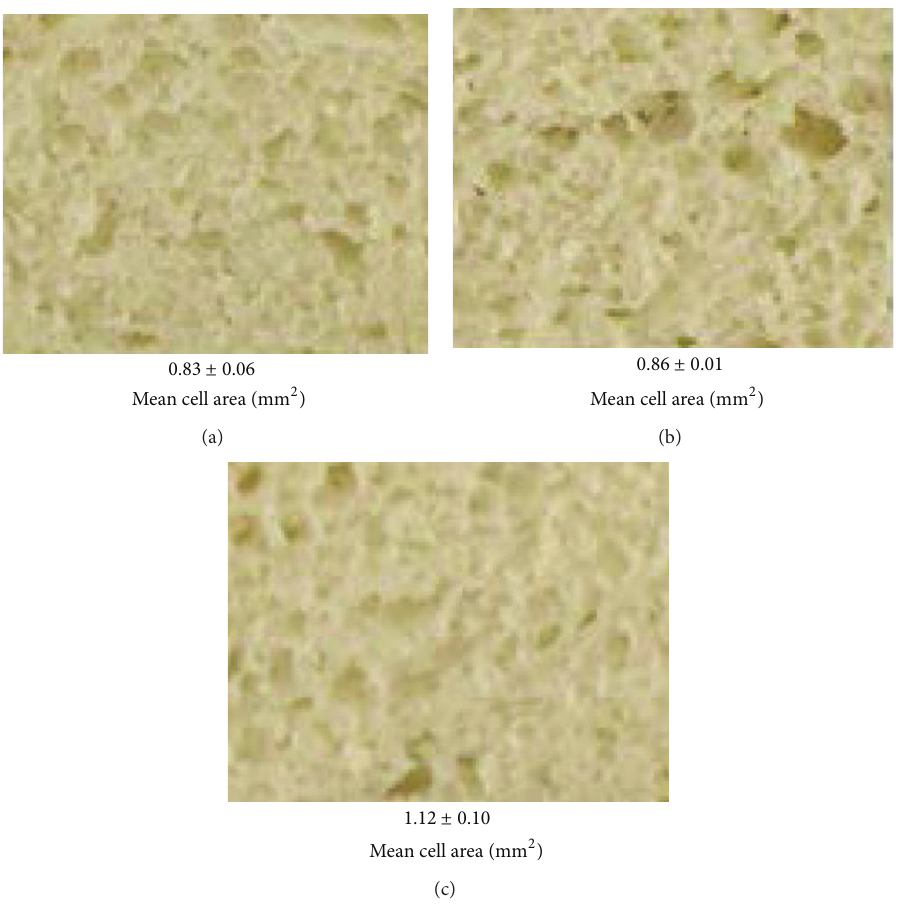
Figure 3: Crumb grain structure showing the mean cell area (mm 2 ) for composite cassava-maize-wheat bread (a) without improvers; (b) +CMC; and (c) +HM pectin.